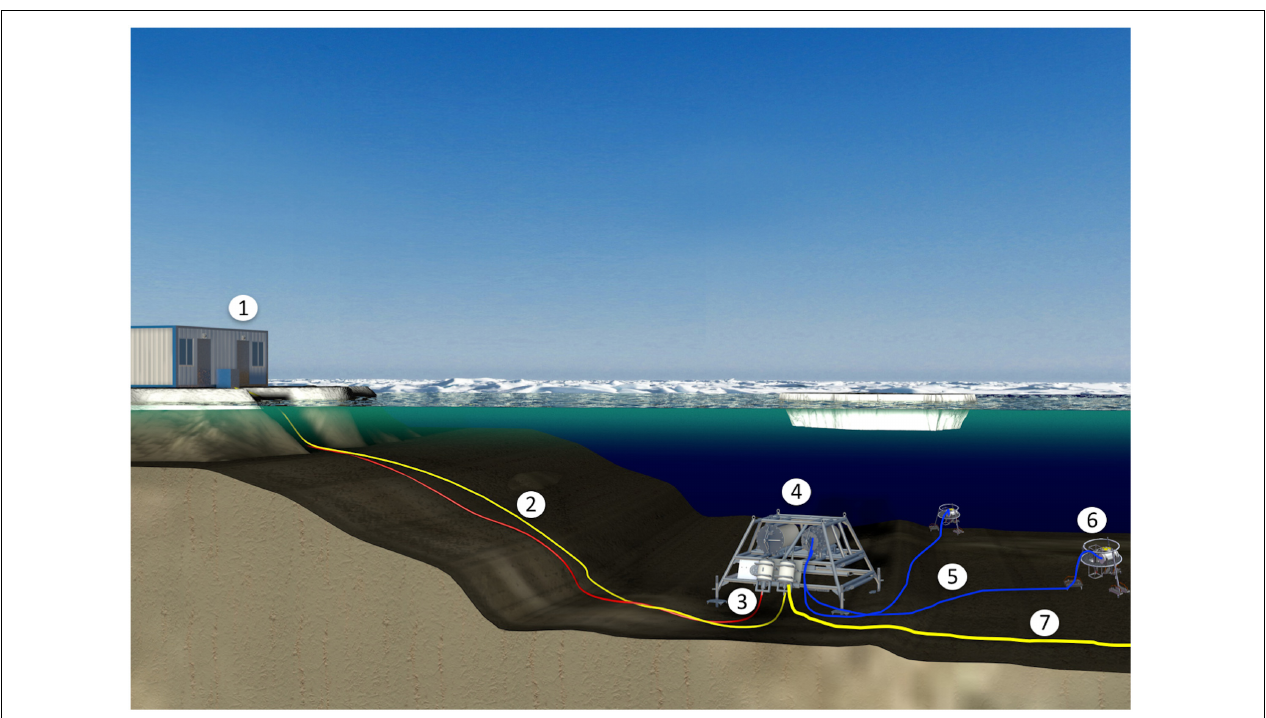
FIGURE 2 | Basic deployment concept of the COSYNA Underwater Node System: (1) land station, (2) submarine cable (1000V), (3) breakout box, (4) underwater node, (5) Power (48V)/TCP-IP hybrid cable, (6) sensor carrier (lander), and (7) submarine cable (1000V) to daisy chained second node. The maximum distance from land station to the first node respectively among the daisy chained second and third nodes is 10 km. Maximum water depth is 300 m. See text for a detailed description of the single